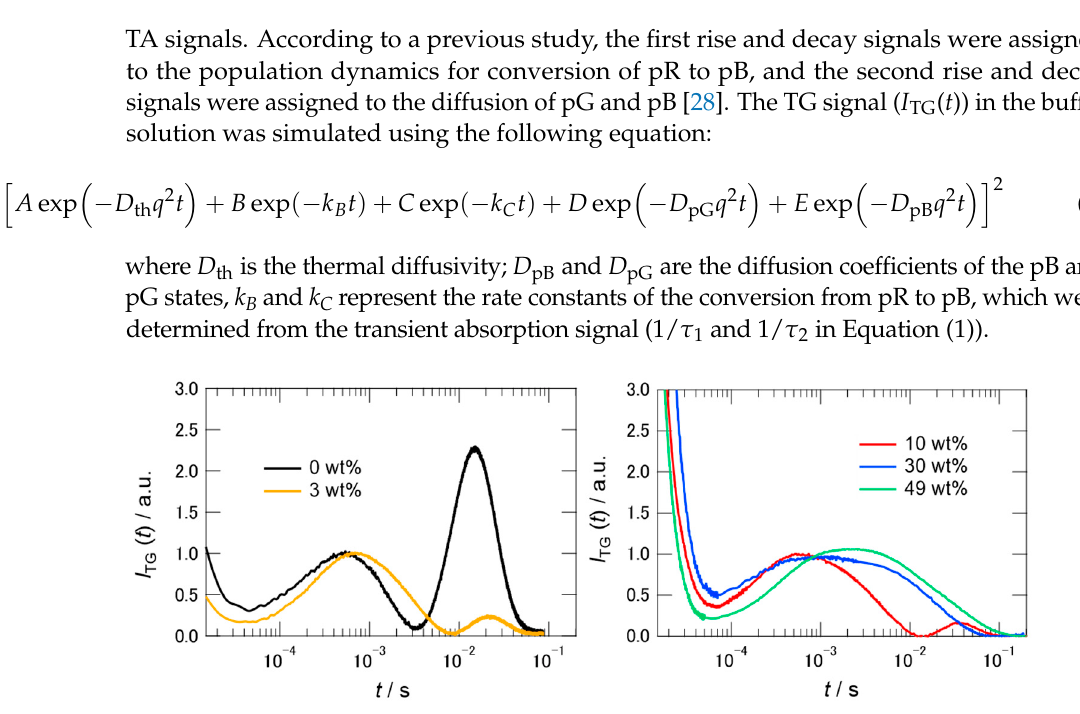
Figure 4. Typical TG signals of PYP in buffer and 3 wt % of [ch][dhp] (left), and in different wt% of [ch][dhp] (right). The values of q 2 are 6.33 × 10 11 m − 2 (left), and 5.08 × 10 11 m − 2 (10 wt%), 6.60 × 10 11 m − 2 (30 wt%), and 7.20 × 10 11 m − 2 (49 wt%) (right). The signal intensities were normalized relative to the peak at 10 − 3 s.